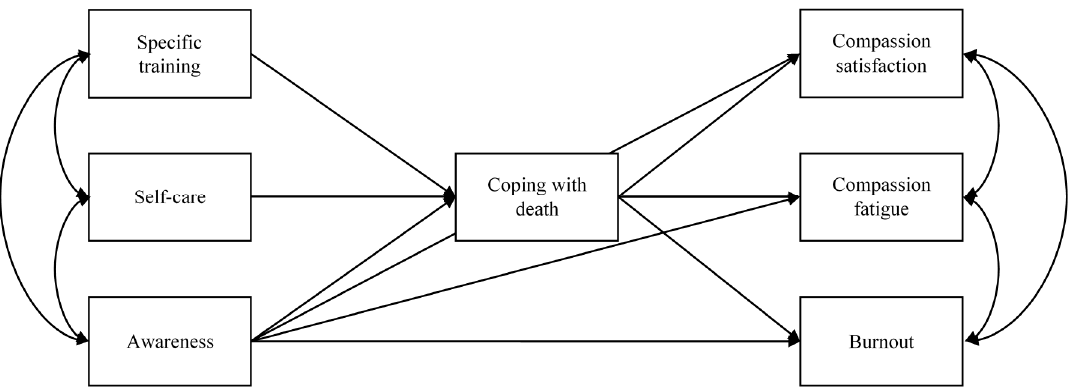
Figure 1. A priori structural model, based on an adaptation of Kearney and Weininger’s model [38], validated by Sansó et al. [39] for the Spanish context.